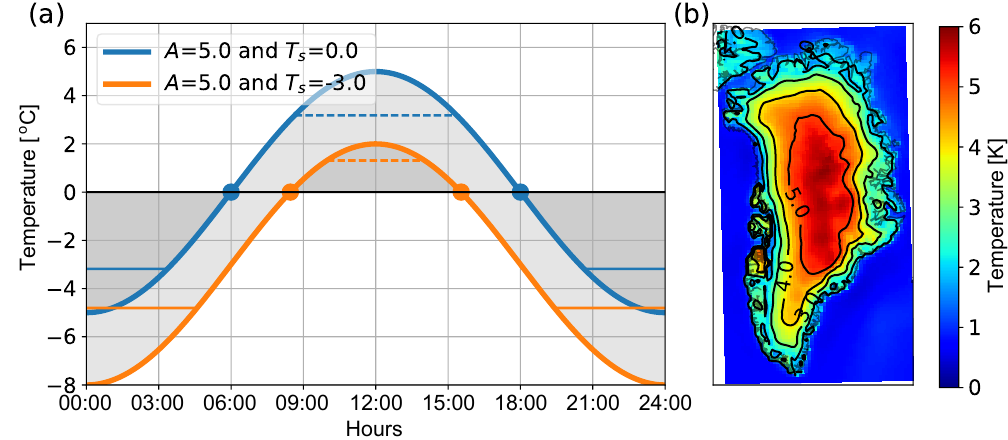
Figure 1. The diurnal cycle parameterised as a cosine function with amplitude A around the mean temperature T s (a) . The dashed horizontal line marks the analytical solution of the average above-mean temperature T + s , and the solid horizontal lines mark the below-mean temperature T − s (see Eq. a and b). The circles denote the roots of the sinusoidal temperature cycle curve. The mean diurnal cycle amplitude of air temperature for the summer season (JJA) in MAR for the years 1990–1999 (b) .